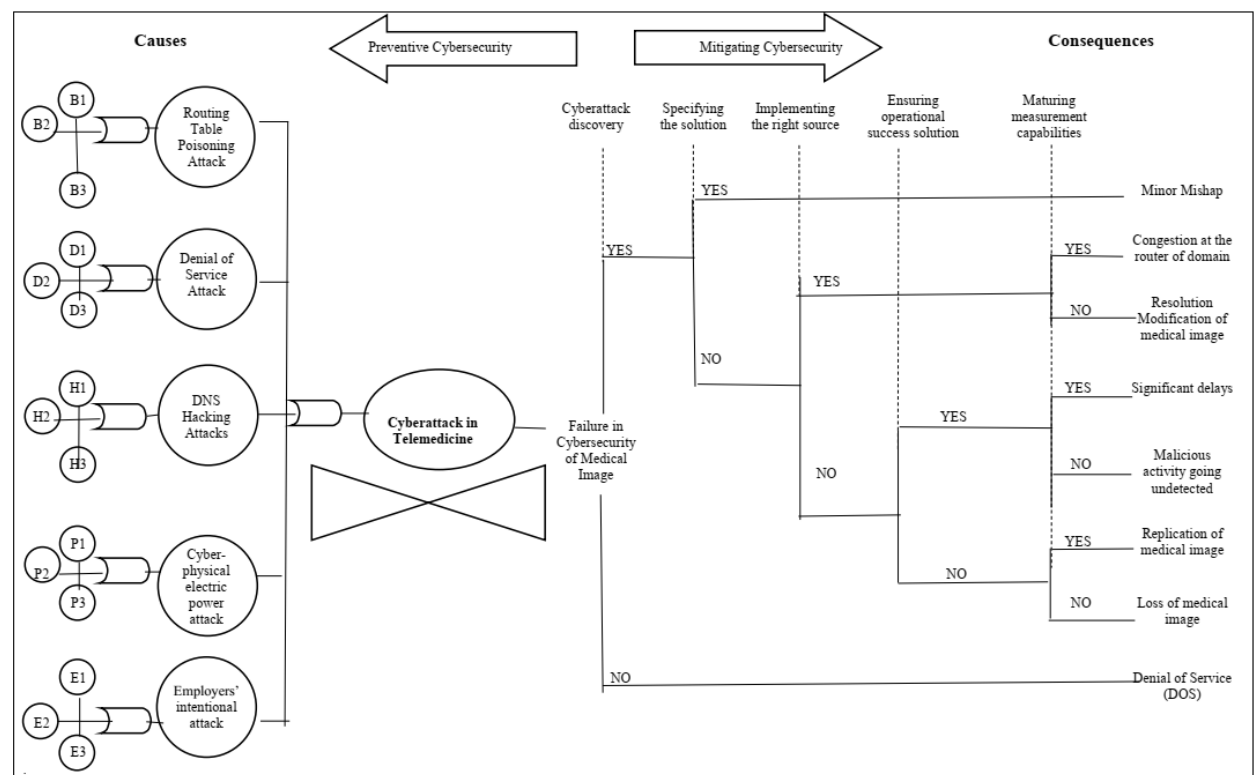
Figure 6. Bow-tie risk analysis for cybersecurity in telemedicine.